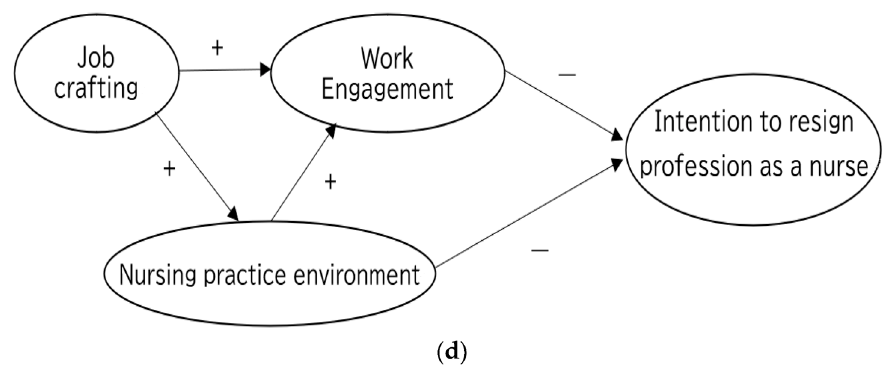
Figure 1. ( a ): Hypothesized model (Model 1) for antecedents and outcome (strength-oriented care attitudes) of work engagement among psychiatric nurses. ( b ): Hypothesized model (Model 2) for antecedents and outcome (mental health) of work engagement among psychiatric nurses. ( c ): Hy- pothesized model (Model 3) for antecedents and outcome (intention to leave current workplace) of work engagement among psychiatric nurses. ( d ): Hypothesized model (Model 4) for antecedents and outcome (intention to resign from their profession as a nurse) of work engagement among psy- chiatric nurses. Note: + means the hypothesized relationship is positive, − means the hypothesized relationship is